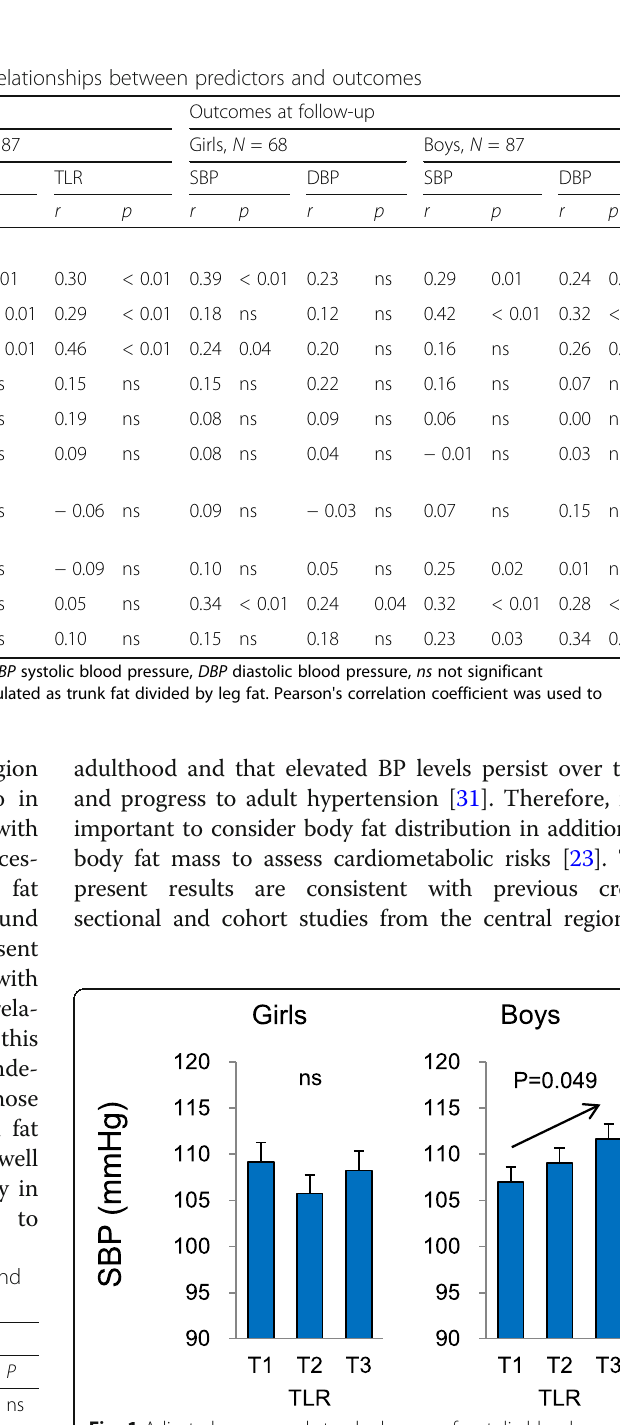
TAR trunk-to-appendicular fat ratio, TLR trunk-to-leg fat ratio, β standardized partial regression coefficient, N number, SBP systolic blood pressure, ns not significant, DBP diastolic blood pressure TAR was calculated as trunk fat divided by appendicular fat. TLR was calculated as trunk fat divided by leg fat. Multiple regression analysis was used after adjusting for age, height, pubic hair appearance, whole body fat, and SBP/DBP at baseline. P < 0.05 was considered statistically significant